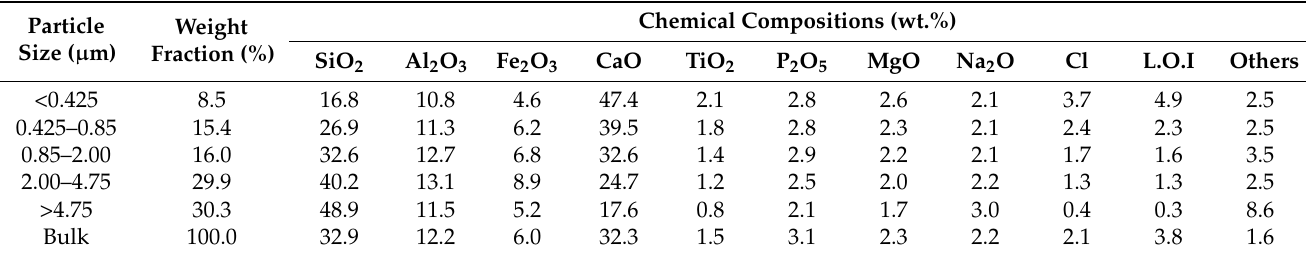
Table 2. Chemical compositions of MSWI bottom ash with different particle sizes